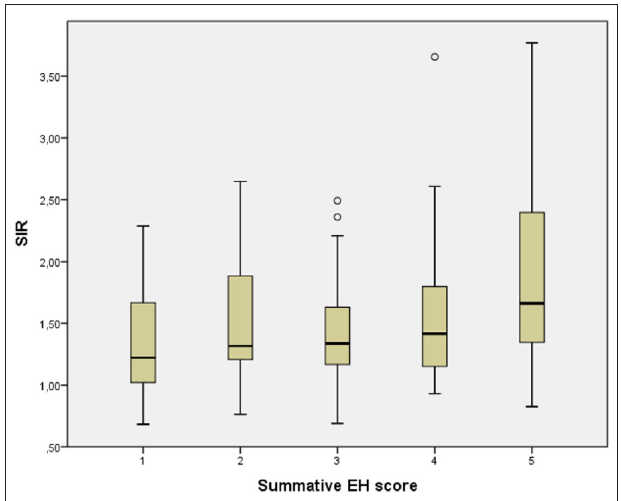
FIGURE 3 | Correlation between signal intensity ratio (SIR) and summative endolymphatic hydrops (EH) score in unilateral hydropic ear disease (HED).